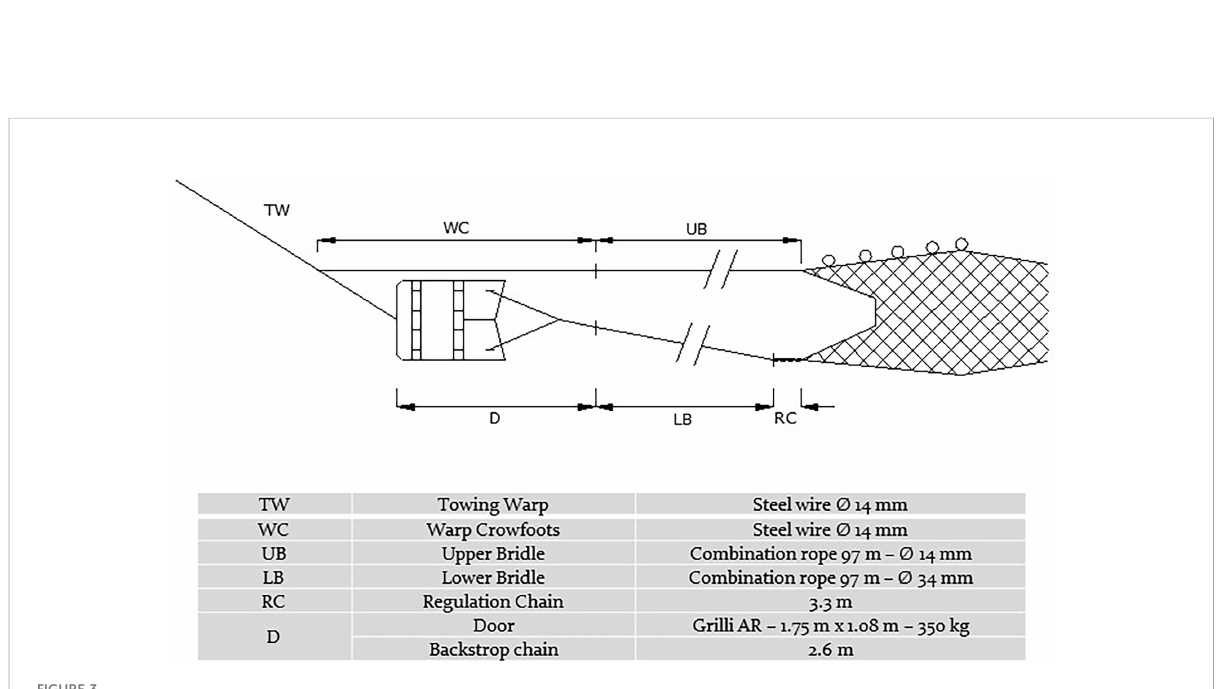
FIGURE 3 Characteristics of the trawl used for the experiment.